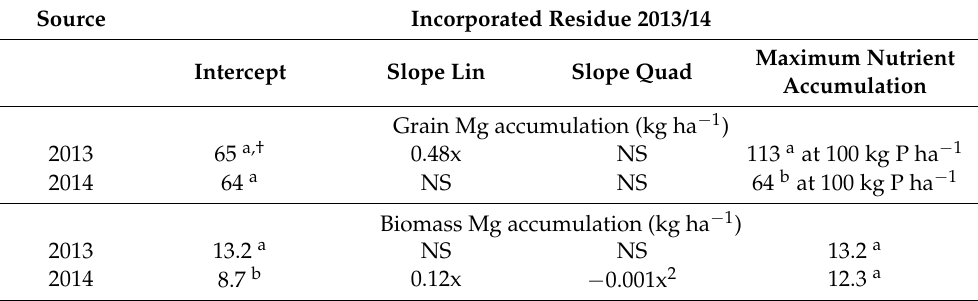
Table 3. Grain and biomass Mg accumulation under incorporated residue management as a function of P 2 O 5 rates and years (2013 and